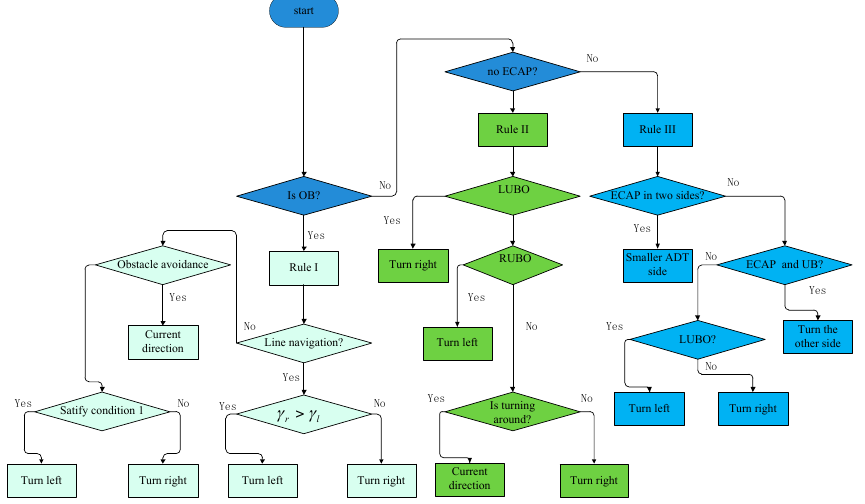
Figure 5. The flowchart for obstacle avoidance rules.